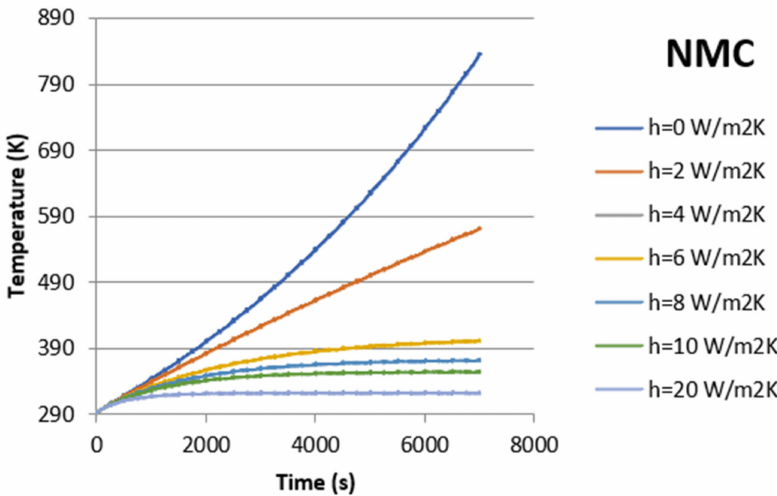
Figure 6. Temperature profile for an NMC cell in the absence of exothermic reactions.